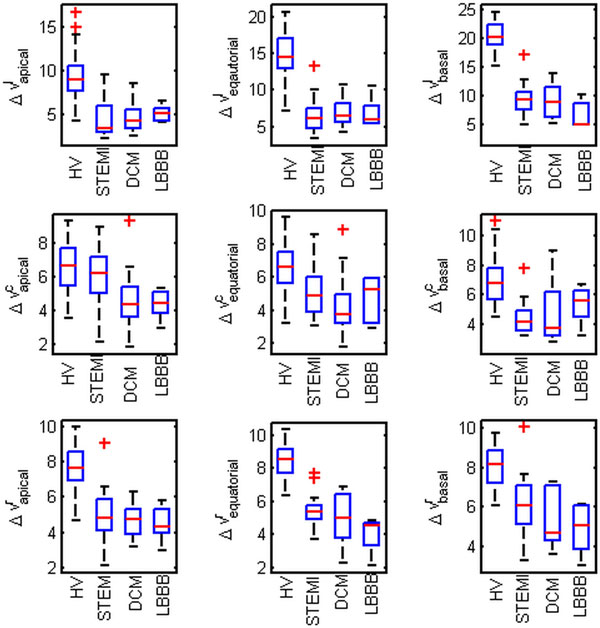
Distribution of velocity ranges (Δv = vmax - vmin) in radial (r), circumferential (c) and longitudinal (l) direction for apical, equatorial and basal slices. Ranges are decreased in all patient cohorts compared to volunteers.